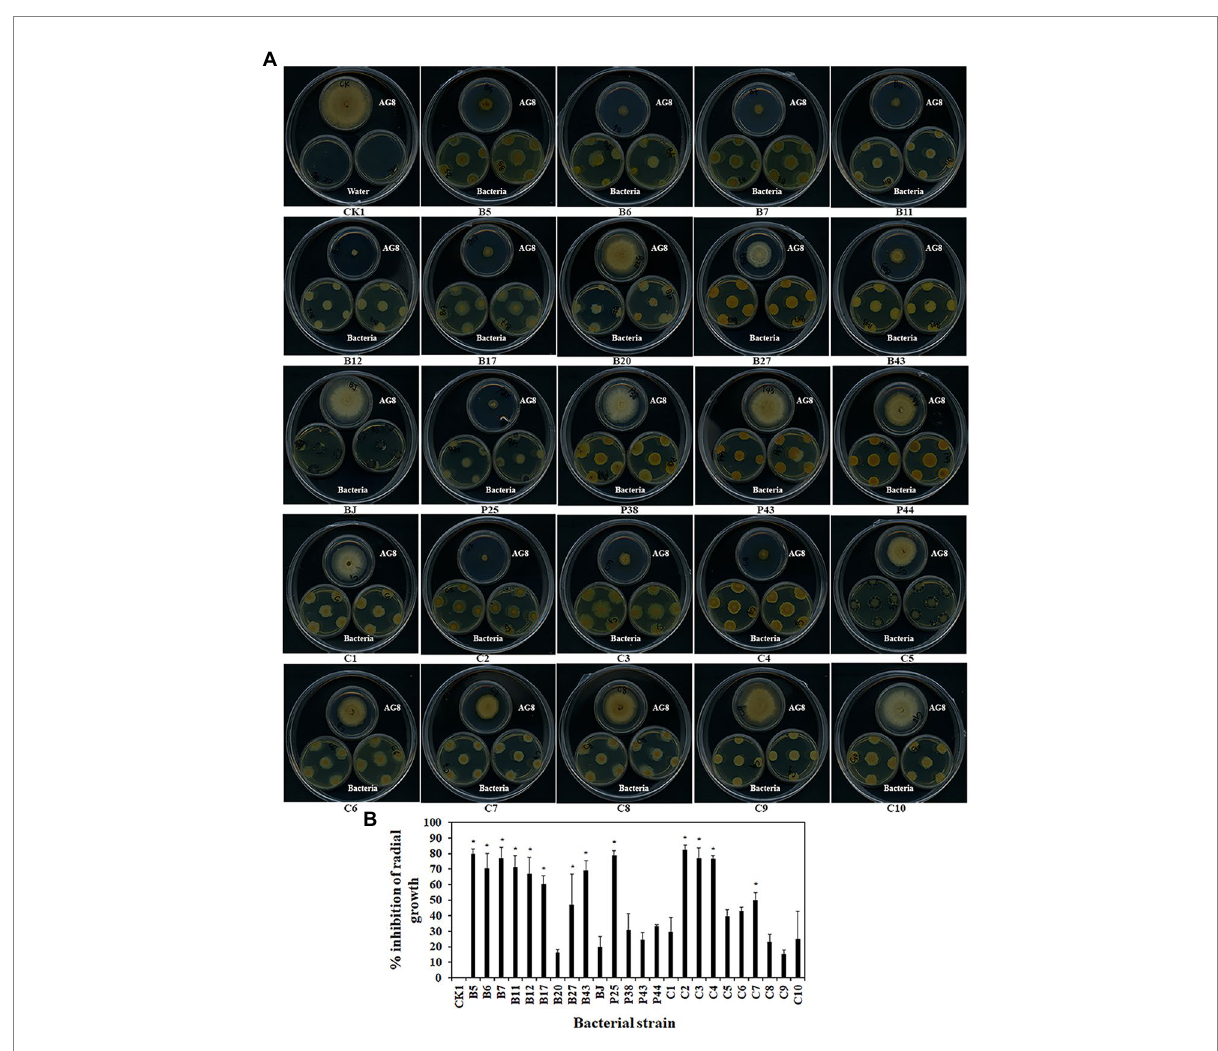
FIGURE 4 Effects of bacterial volatiles on the growth of R. solani AG8. (A) . The growth of AG8. (B) . Inhibition of radial growth of AG8. CK1: ddH 2 O; B5: Pseudomonas sp. B5; B6: Streptomyces sp. B6; B7: Chryseobacterium sp. B7; B11: Pseudomonas sp. B11; B12: Pseudomonas sp. B12; B17: Sphingomonas sp. B17; B20: Cupriavidus campinensis B20; B27: Asticcacaulis sp. B27; B43: Rhodococcus erythropolis B43; BJ: Janthinobacterium lividum BJ; P25: Pseudomonas sp. P25; P38: Chryseobacterium soldanellicola P38; P43: Chryseobacterium sp. P43; P44: Pedobacter sp. P44; C1: SynCom 1; C2: SynCom 2; C3: SynCom 3; C4: SynCom 4; C5: SynCom 5; C6: SynCom 6; C7: SynCom 7; C8: SynCom 8; C9: SynCom 9; C10: SynCom 10. The values are means ± SD. Asterisks indicate significant differences ( p ≤ 0.05, Dunn test, n =